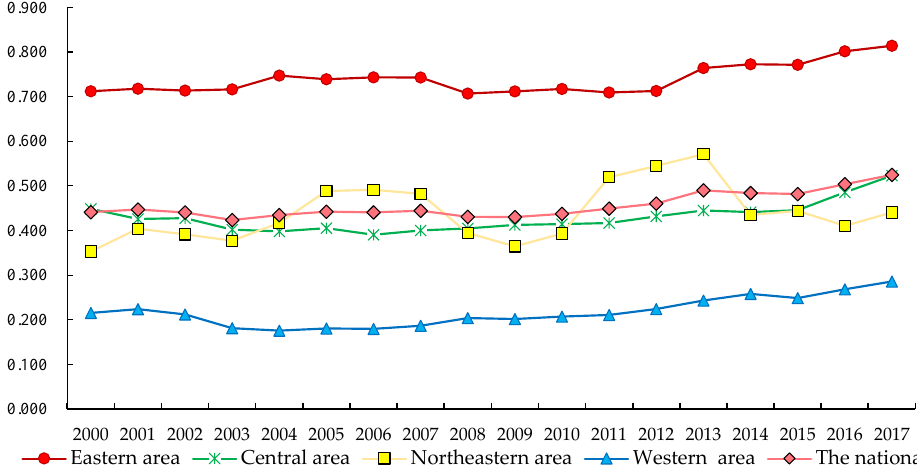
Figure 1. The evolution trend of tourism eco-efficiency in China and four sub-regions from 2000 to